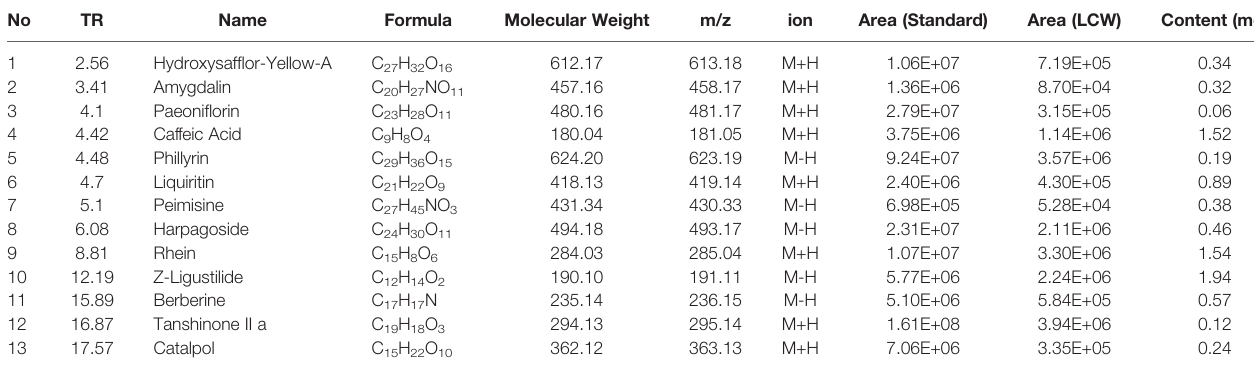
TABLE 1 | Information of chemical components in